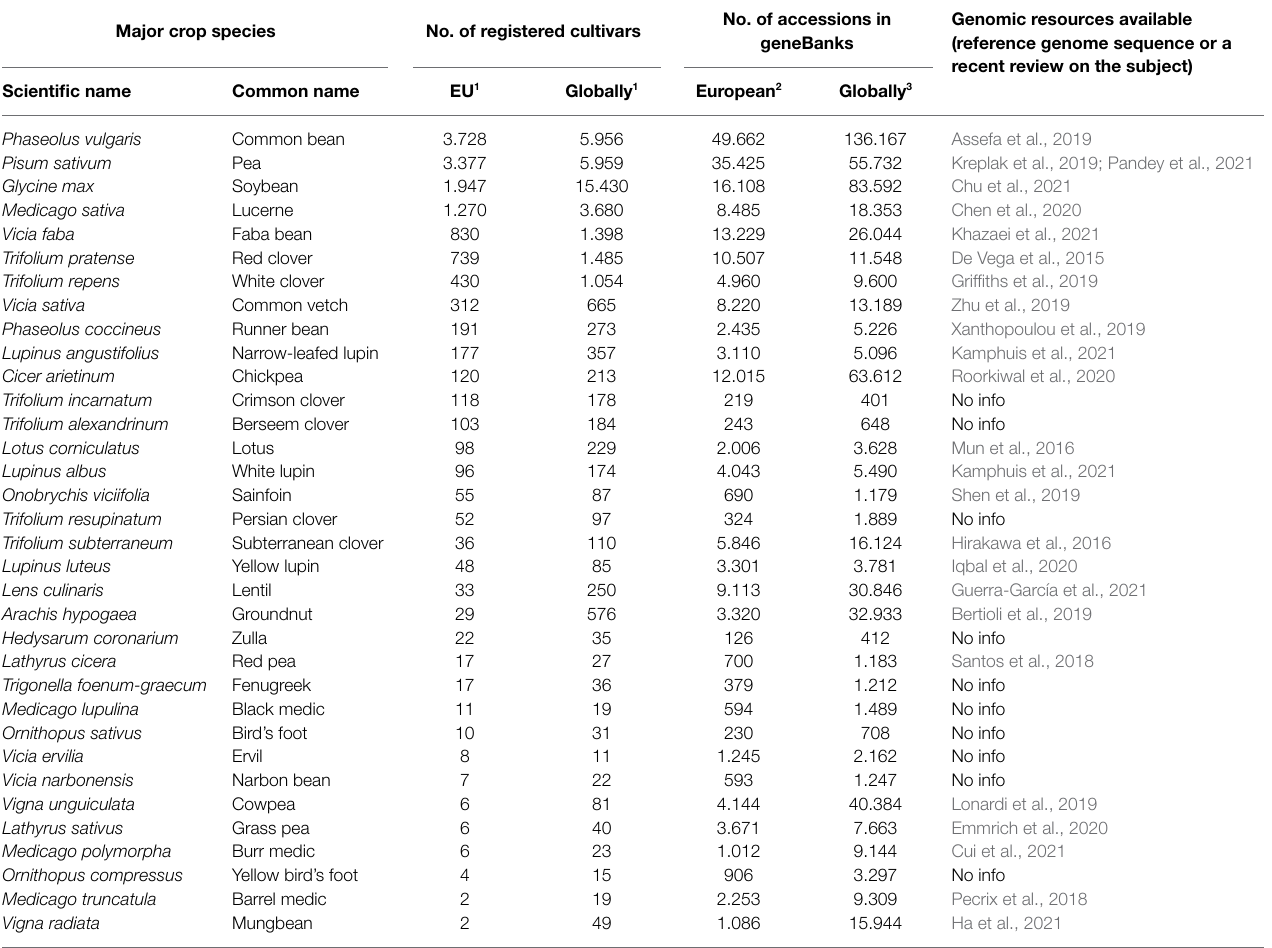
TABLE 1 | Major legume crops ranked by the number of cultivars registered in the EU as an indication of breeding efforts devoted to them. Major crop species No. of registered